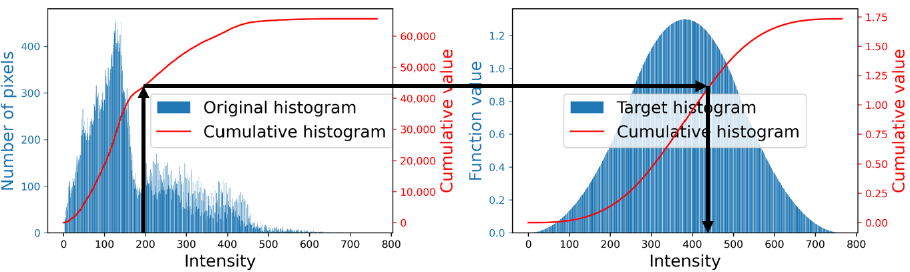
Figure 1. The left and right graphs show the original and target histograms with blue bars, and their cumulative counterparts are also shown in red curves. An input intensity is transformed into the output one as indicated by black